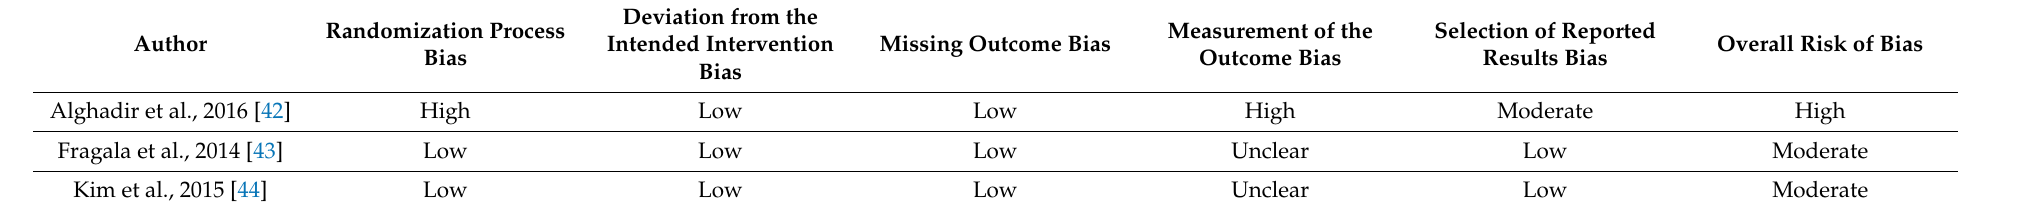
Table 2. RoB 2 quality assessment scores for RCTs included